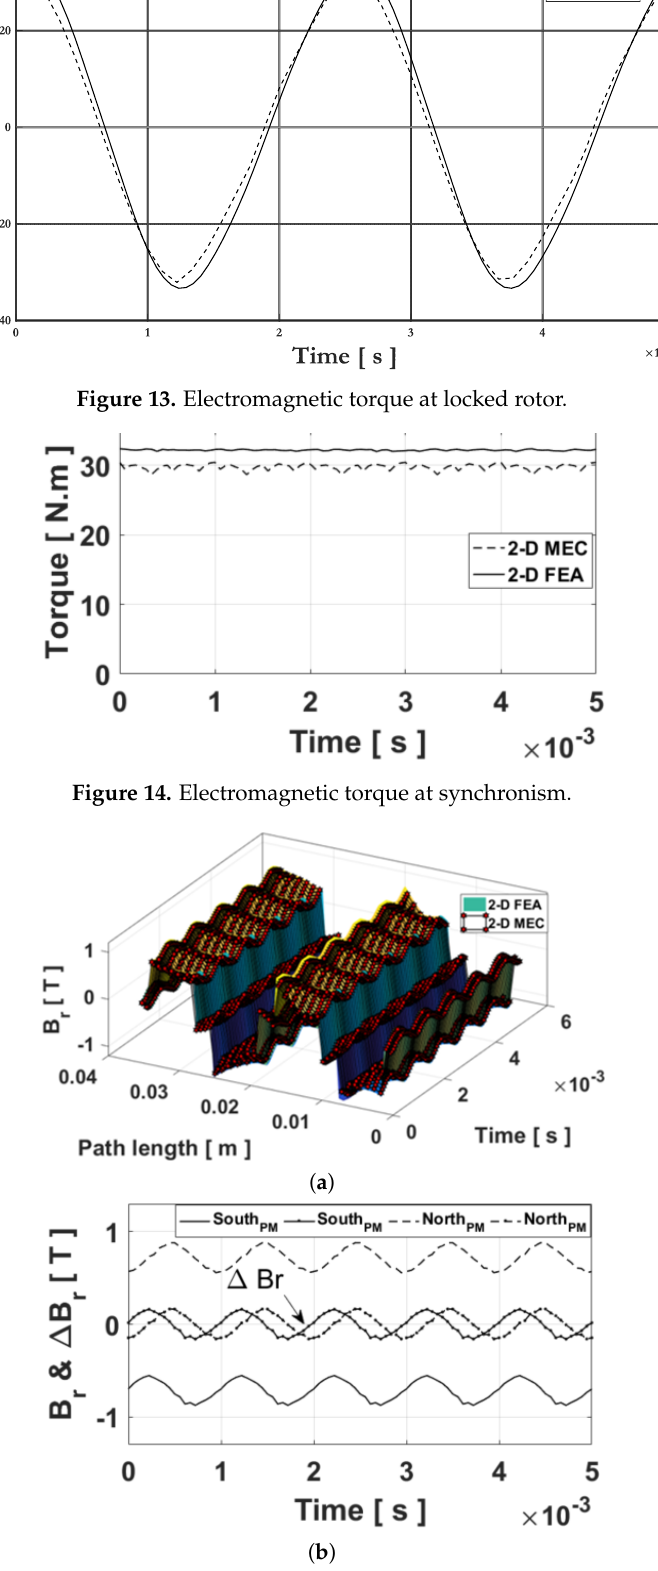
Figure 15. Evolution of B : ( a ) versus time for the path crossing the middle of PMs, and ( b ) in the middle of North and South PMs with(out) the average